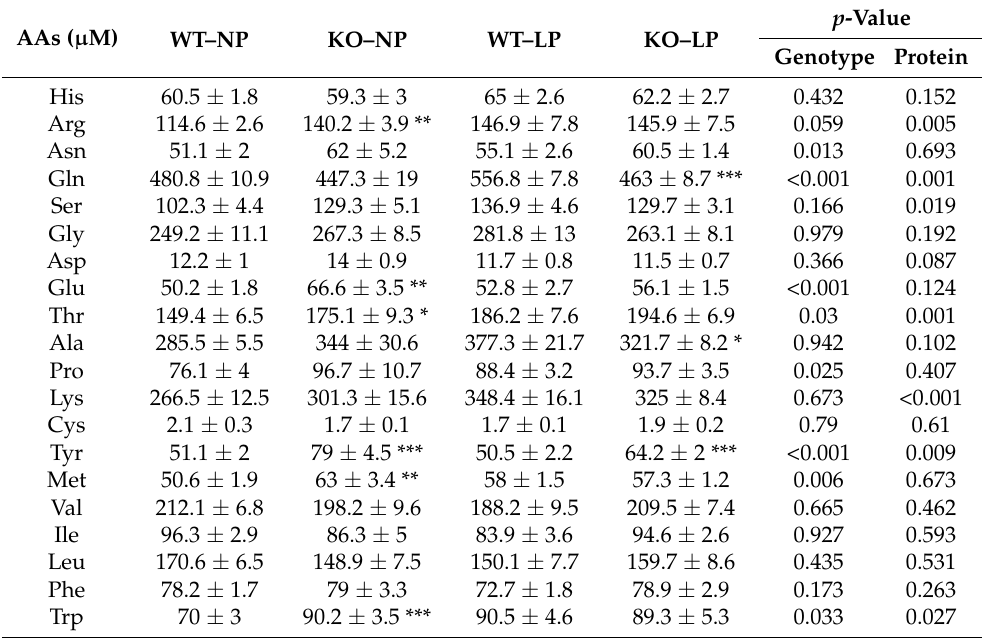
Table 2. Effect of the loss of GPRC6A on serum free amino acids in mice fed different protein